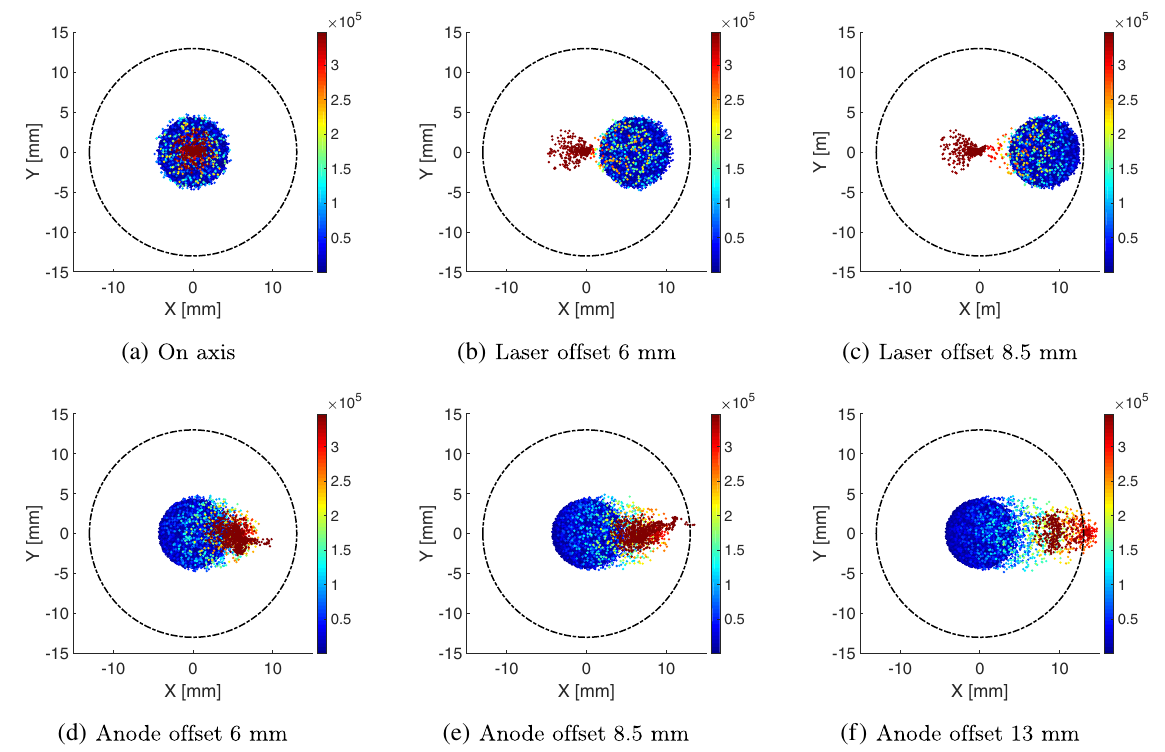
FIG. 7. Simulated ion distribution on the cathode. Available cathode diameter is 26 mm, represented by the dotted black circle. Laser spot is 8.6 mm in diameter, represented by the blue circle. The color bar represents the energy of the bombarding ions in eV. Electrostatic center for the cathode is at coordinate